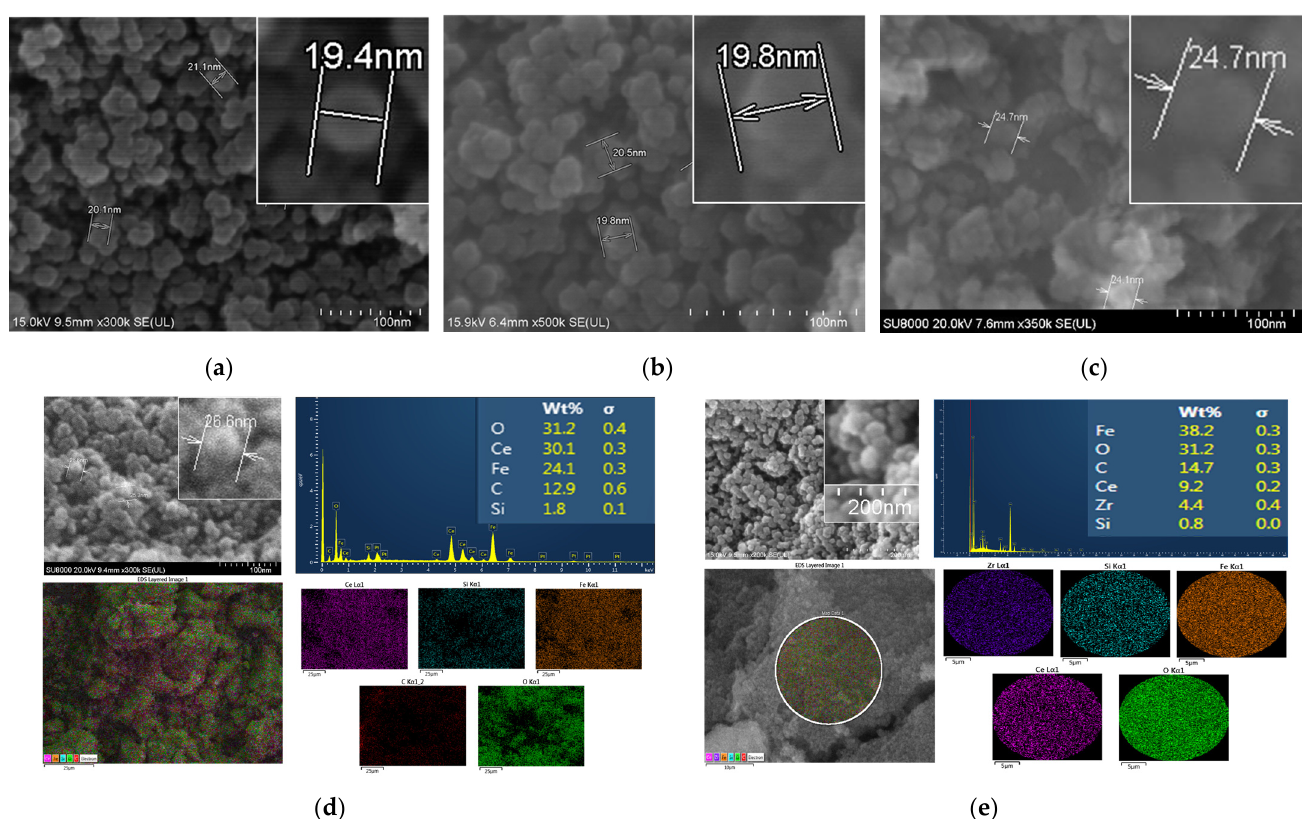
Figure 5. Field Emission-Scanning Electron Microscope (FE-SEM) images for nanoparticle sizing of: ( a ) Fe 3 O 4 , ( b ) Fe 3 O 4 @CeO 2 and ( c ) Fe 3 O 4 @CeO 2 -APTES; EDS analysis for ingredient identification of: ( d ) Fe 3 O 4 @CeO 2 -APTES-HA and ( e ) Fe 3 O 4 @CeO 2 -APTES- DFO-Zr.